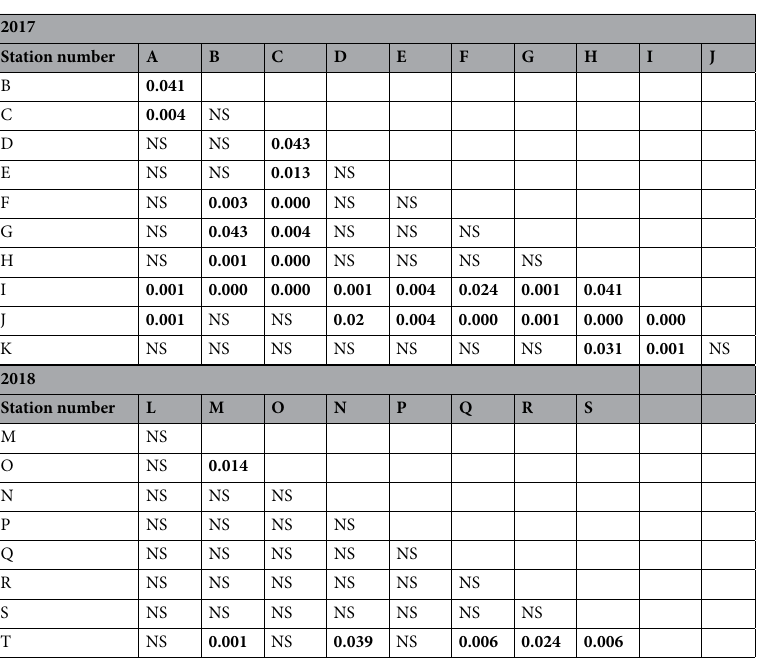
Table 3. Pair-wise Tukey test results exploring the differences in the number of mt16S gene copies [g stomach content] −1 between different sampling stations over two separate sampling periods (years: 2017 and 2018). Only significant p values are displayed (< 0.05). NS not